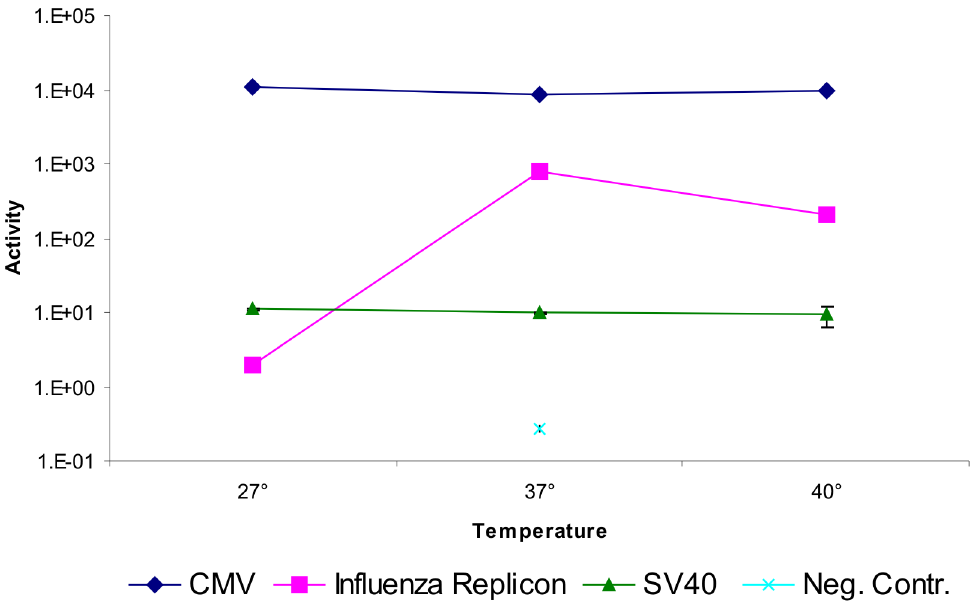
Figure 9. Temperature dependence of the influenza replicon. HEK-293 cells were either tranfected with pcDNA-luc (CMV), pGL3-control (SV40) or with the influenza replicon and pMono-lucNS (Flu Replicon) or with pMono-lucNS and pBi-NP only (Neg. Contr.). Additionally, pRL, coding for Renilla luciferase, was cotransfected in all cases. Four hours post transfection cells were transferred to 27 u C or 40 u C or remained at 37 u C. Cells were harvested 48 hours post transfection and were subjected to luciferase assay. Firefly values have been normalized to Renilla values. Data represents arithmetic mean values and standard deviation.